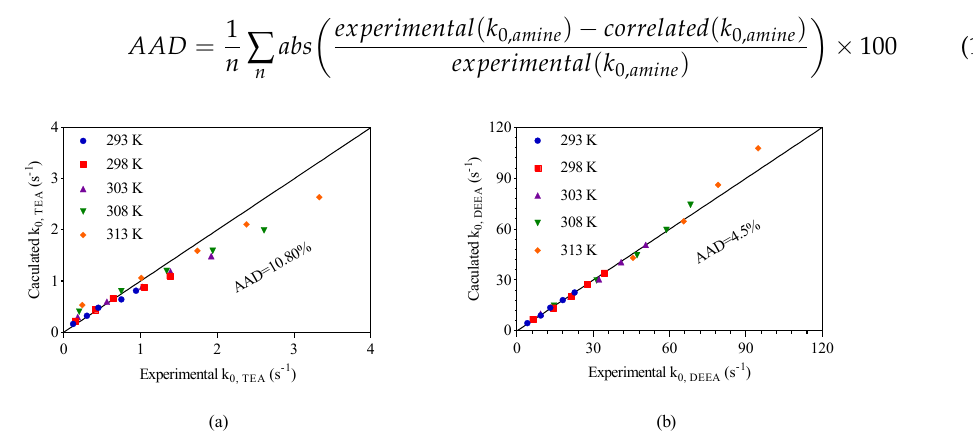
Figure 5. A comparison between the calculated k 0, amine values and that of collected experimental results : ( a ) TEA–CO